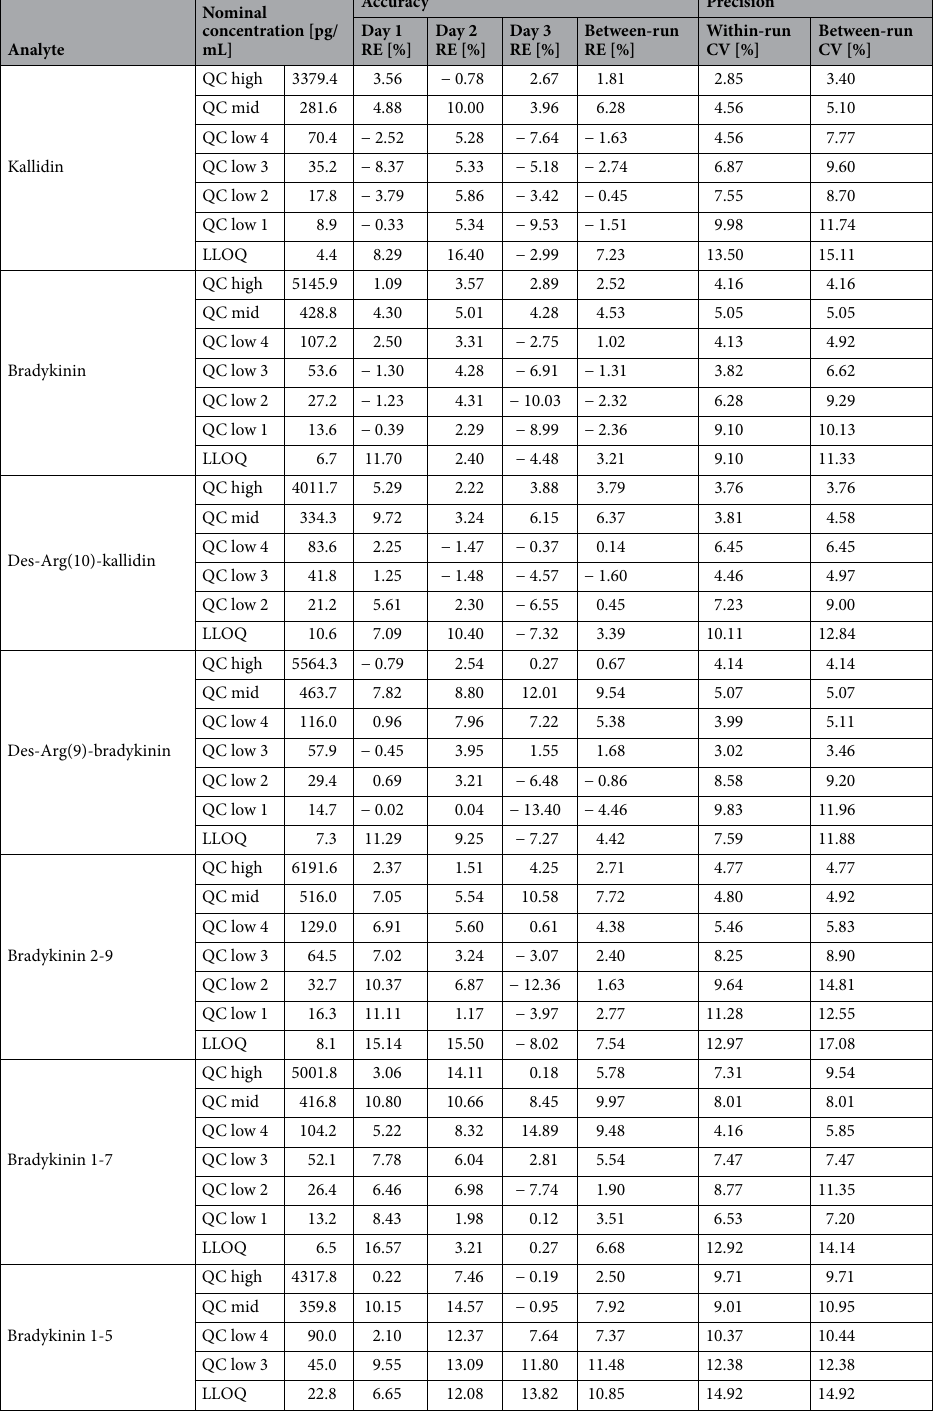
Table 3. Accuracy and precision results for all analytes. Using one-way ANOVA, within-run precision was calculated as the repeatability and between-run precision as the day-different intermediate precision. CV: coefficient of variation, LLOQ: lower limit of quantification, QC: quality control, RE: relative